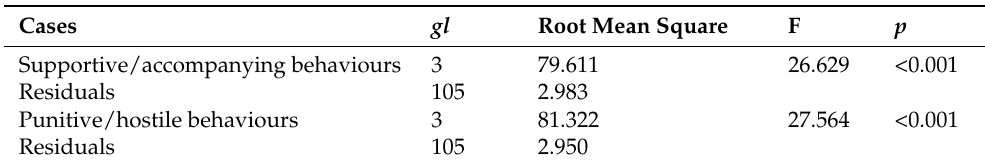
Table 5. Programme statistical significance on parenting behaviours.